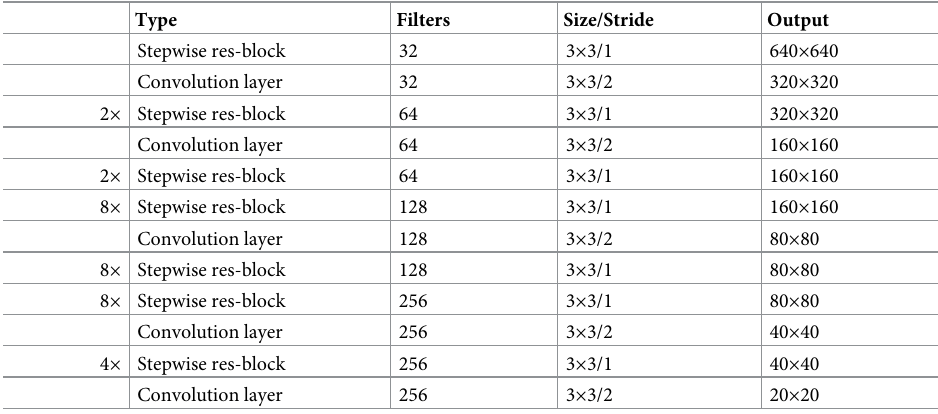
Table 3. The structure of